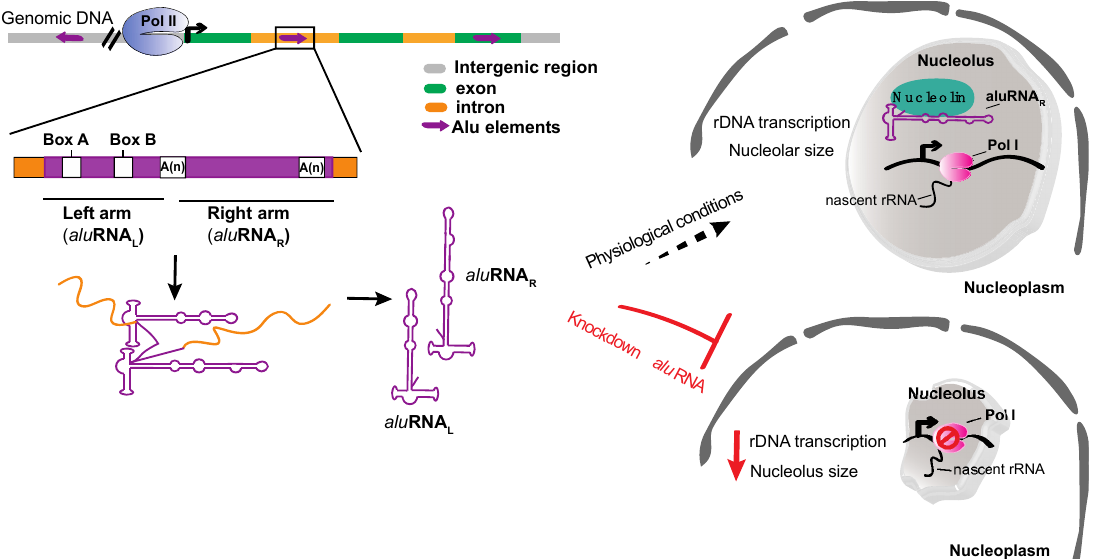
Figure 4. aluRNAs role in promoting the rDNA transcription. alu RNAs are transcribed from Alu elements located in intronic regions by RNA pol II (Pol II). alu RNAs are found as separated monomer units ( alu RNA L and alu RNA R ) in cells and could be accumulated in the nucleolus. Under physiological conditions, alu RNAs bind to nucleolin and promote the rDNA transcription. On the other hand, knockdown of alu RNAs causes disruption of the nucleolar structure and reduces the rDNA transcription.